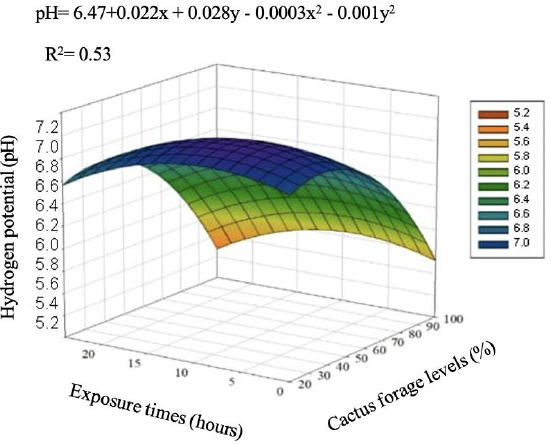
Figure 2. Potential of hydrogen (pH) as a function of cactus forage levels and time of exposure to air. For E. coli population, there was an interaction effect between cactus forage levels and air exposure time ( p < 0.001). The growth pool of this bacterium peaked at 16.06 h of exposure to air (Figure 3).